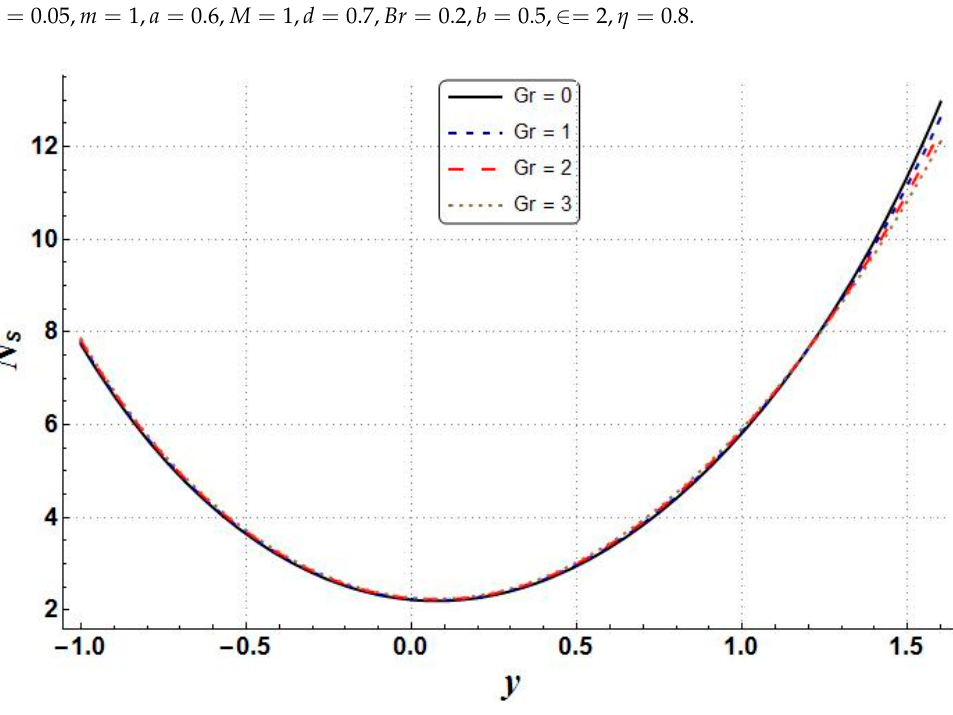
Figure 28. Influence on N S through changing values of Gr , where γ = π α = π , φ = 0.05, k = 2, a = 0.6, M = 1, d = 0.7, m = 1, b = 0.5, ∈ = 2, η = 4